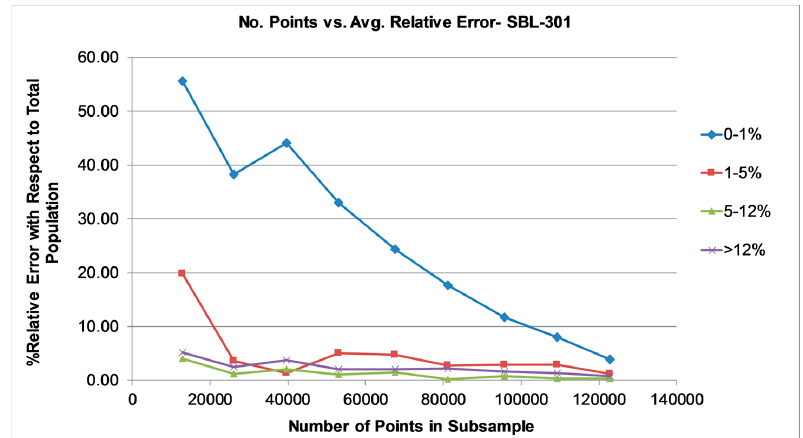
Figure 9. Chart illustrating the effect of the number of analysis points on the repeatability of mineralogical results for minerals present in the percent ranges illustrated in the legend for sample SBL-301. In this case, ~101,000 points are required in order to achieve a relative error of <10% for all of the four mineral modal percent ranges.